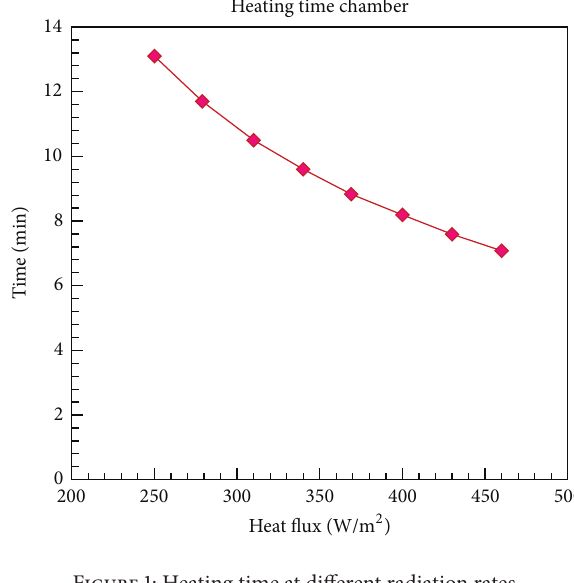
Figure 1: Heating time at different radiation rates.